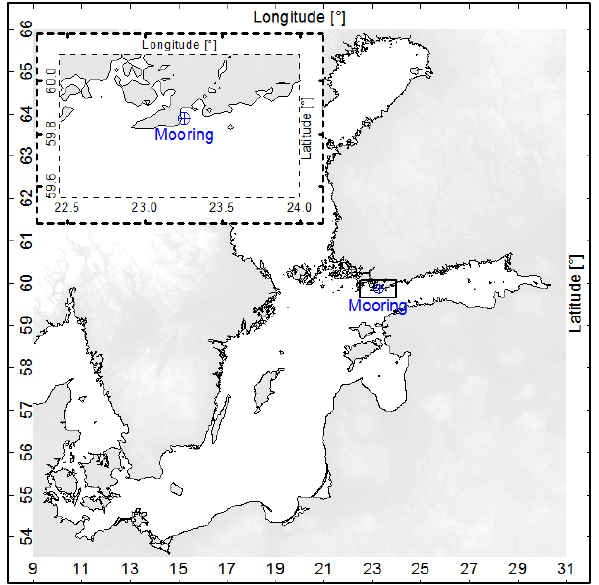
Figure 1. The Baltic Sea and the location near the peninsula Hanko in the western Gulf of Finland where the mesocosms were